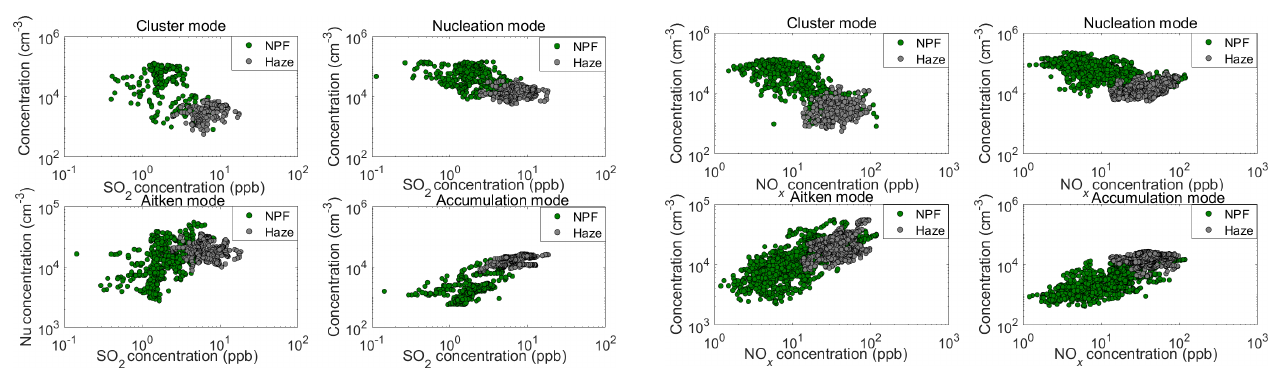
Figure 9. Correlation between the SO 2 concentration and particle number concentration in each mode. The time resolution of the data points was 1h.